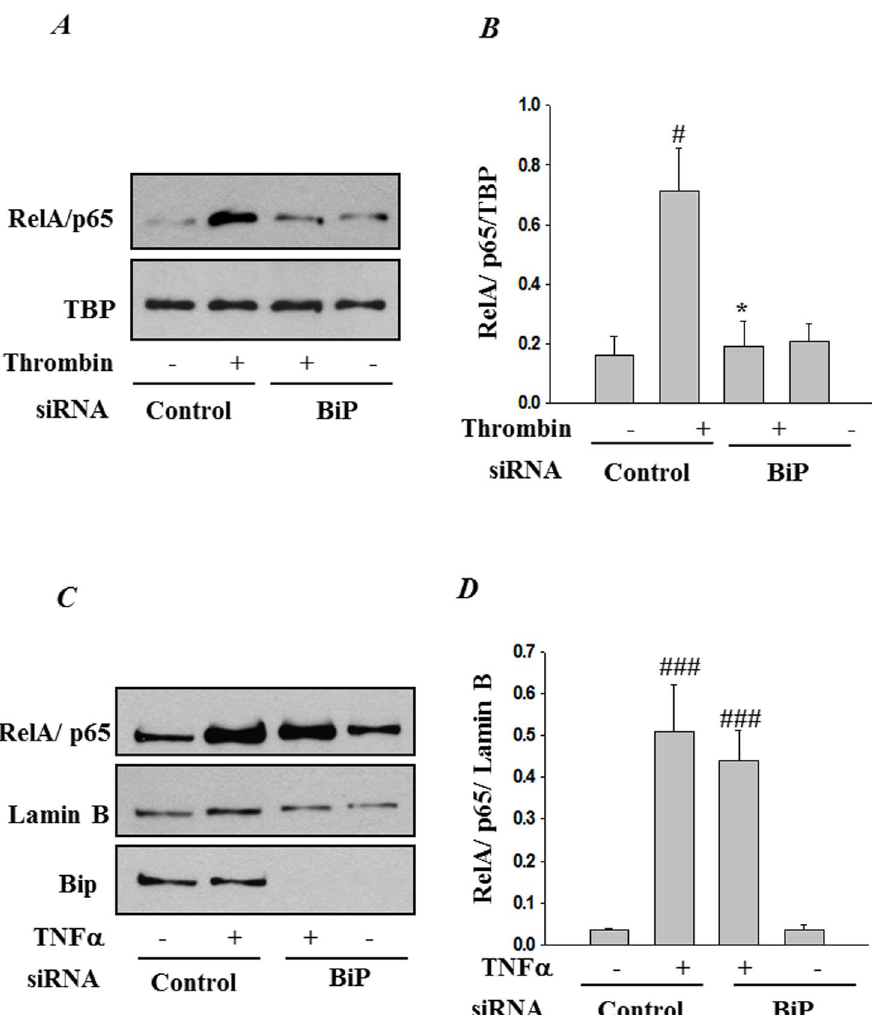
Figure 5. BiP knockdown prevents thrombin-induced RelA/p65 translocation to the nucleus. HPAEC were transfected with control-siRNA or BiP siRNA using DharmaFect1. After 24–36 h, the cells were challenged with ( A ) thrombin (5 U/ml) for 1 h or ( C ) TNF a for 0.5 h. Nuclear extracts (NE) were separated by SDS-PAGE and immunoblotted with anti-RelA/p65 antibody. Tata Binding Protein (TBP) and Lamin B, both nuclear proteins, were used as loading control for nuclear extracts. Anti-BiP antibody was used to monitor BiP depletion. The bar graph represents the effect of BiP knockdown on ( B ) thrombin or ( D ) TNF a -induced nuclear translocation of RelA/p65 normalized to TBP and Lamin B levels respectively. The data are the means 6 S.E. (n=6 for each condition). # p , 0.05 or ### p , 0.001 difference from controls; * p , 0.05 difference from thrombin stimulated